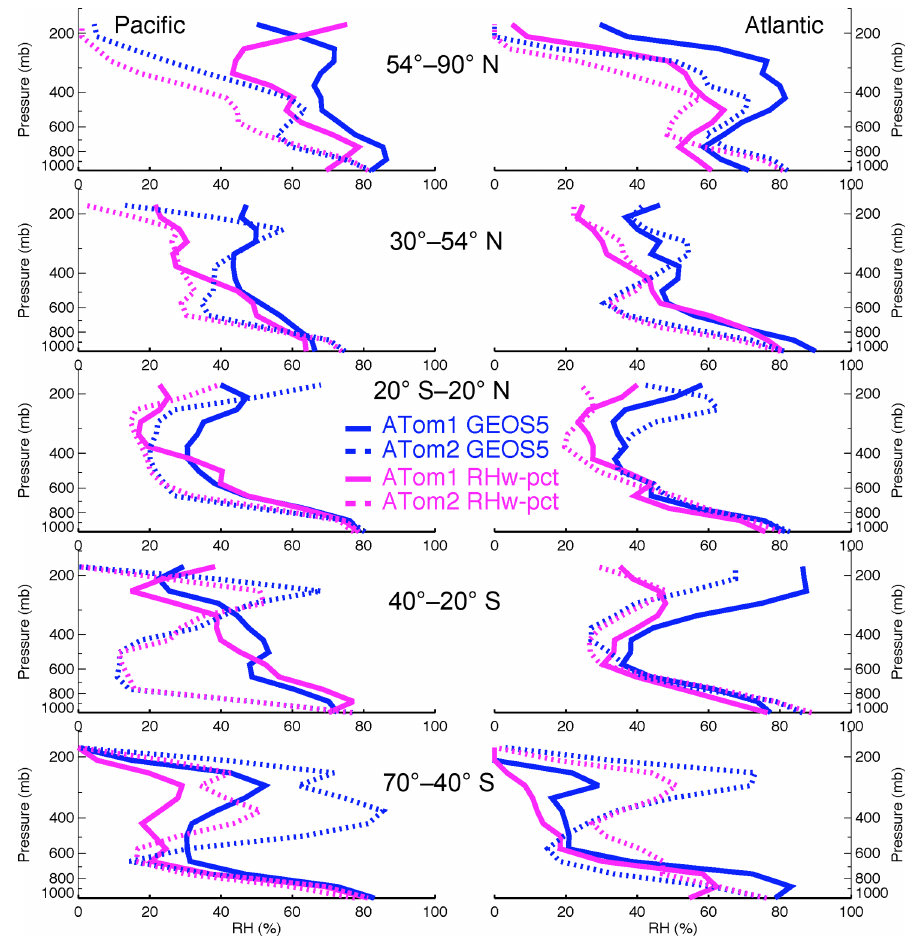
Figure 7. Atmospheric RH vertical profiles from GEOS simulation and ATom measurement along ATom1 and ATom2 flight tracks in five latitudinal bands over the Pacific and Atlantic